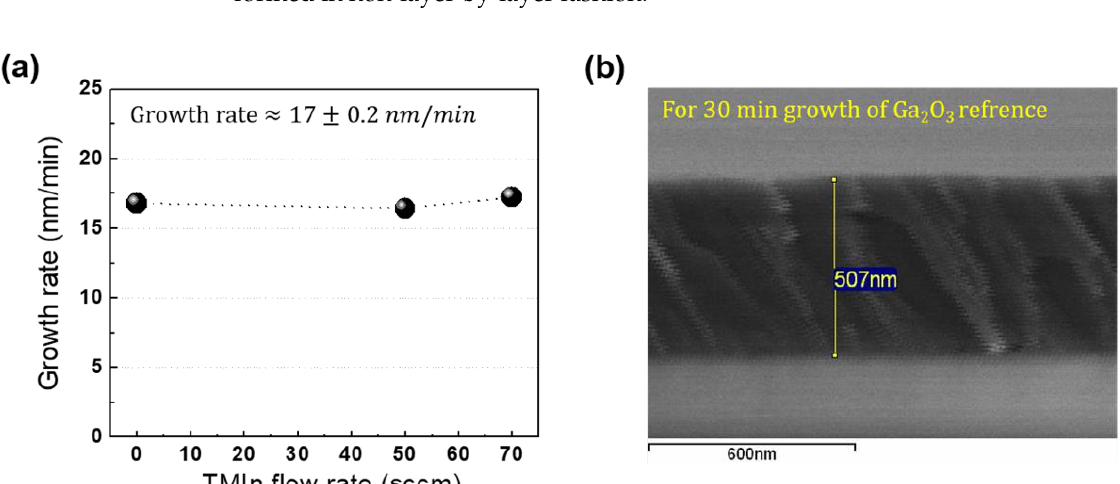
Figure 1. ( a ) The summary of growth rate depending on the Trimethyl-indium (TMIn) flow rate. ( b ) The cross-sectional SEMs image of Ga 2 O 3 reference growth.